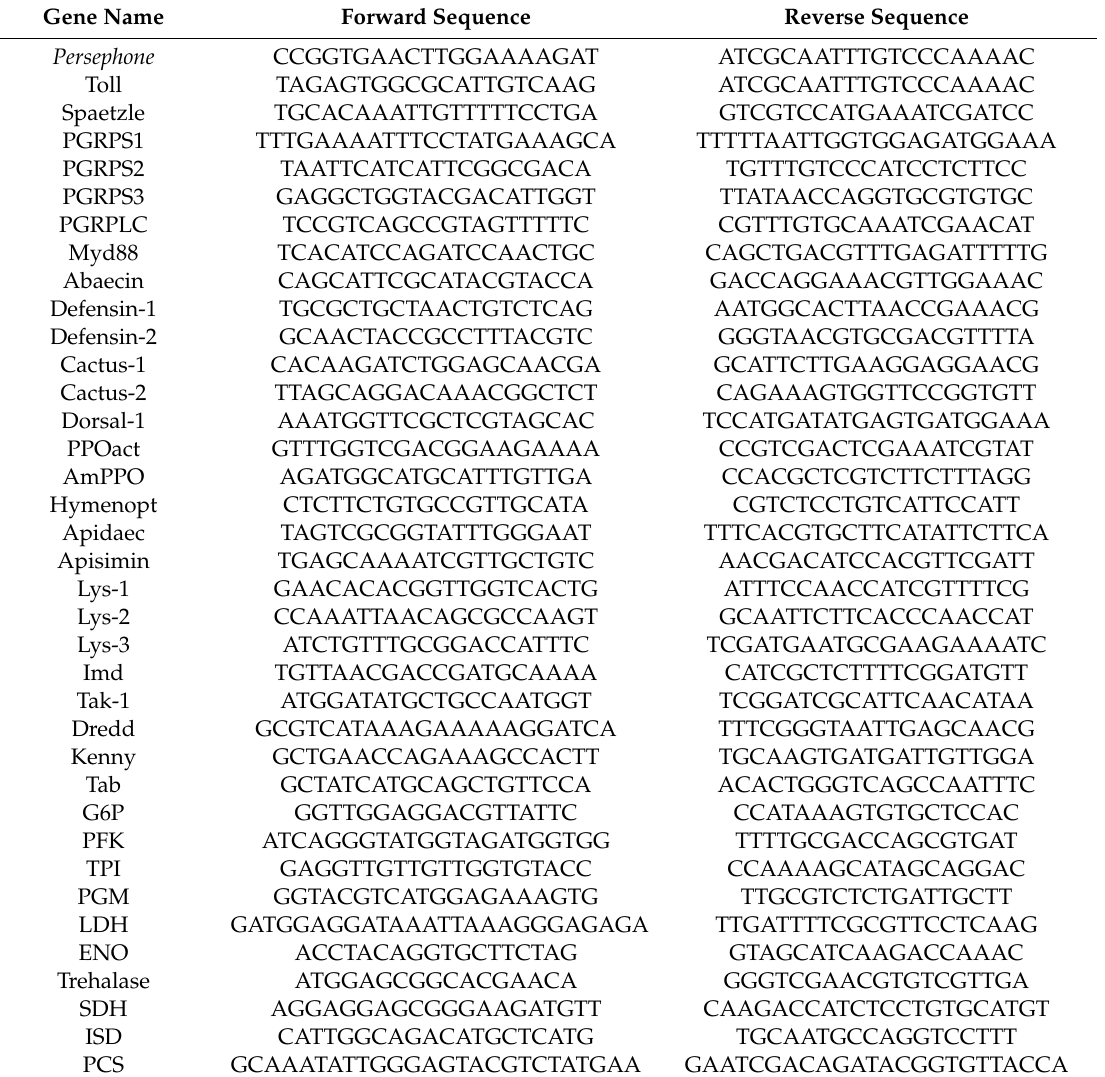
Table 1. List of real-time polymerase chain reaction (RT-PCR) primers and target